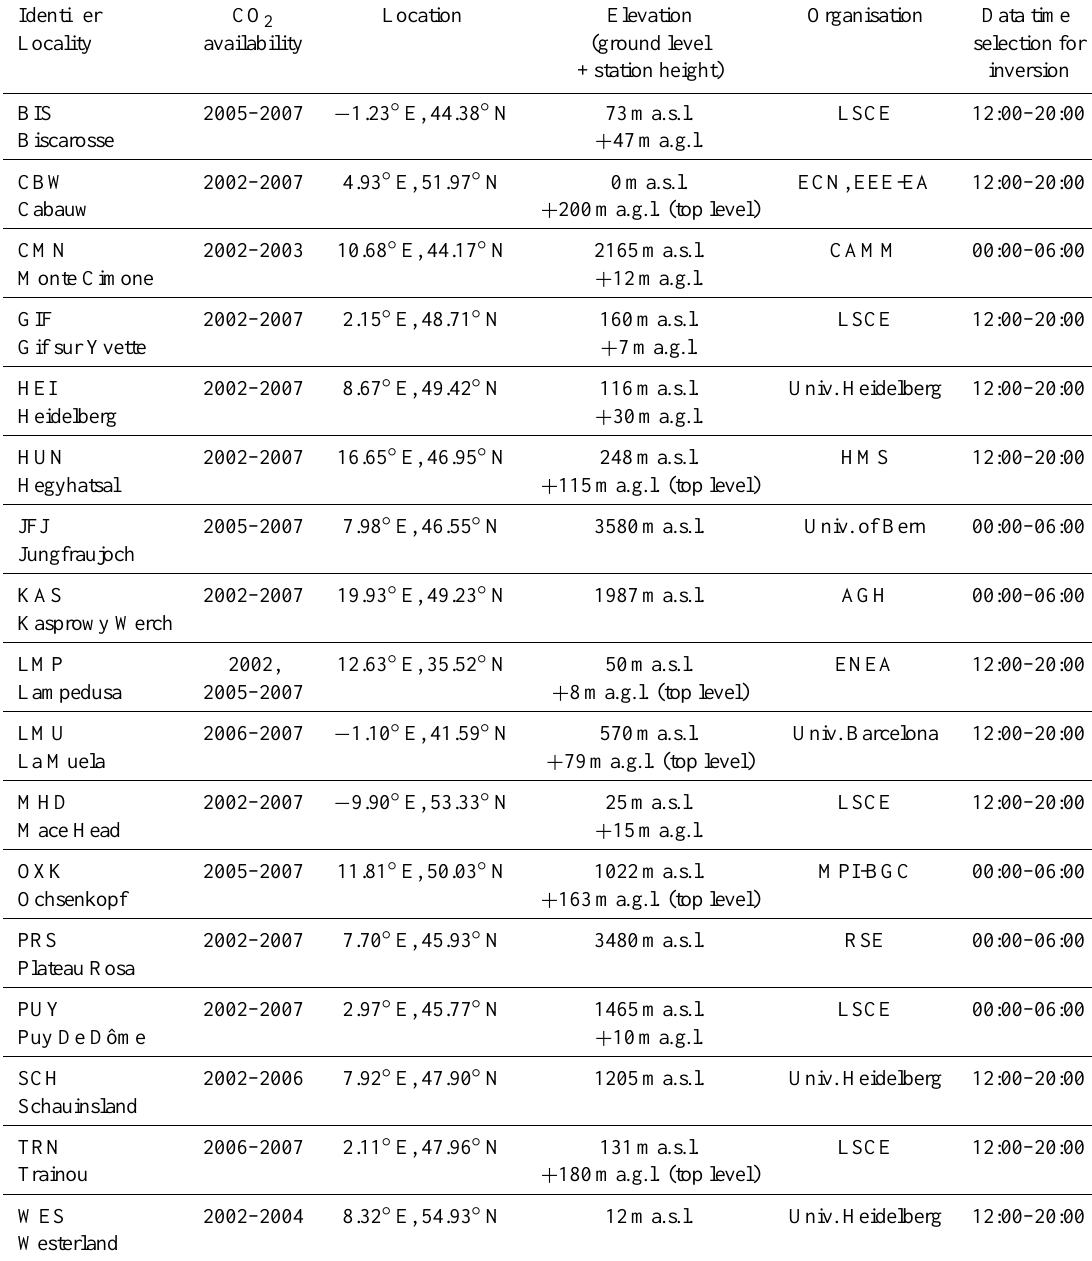
Table 1. CE atmospheric stations providing the CO 2 measurements used in this study.